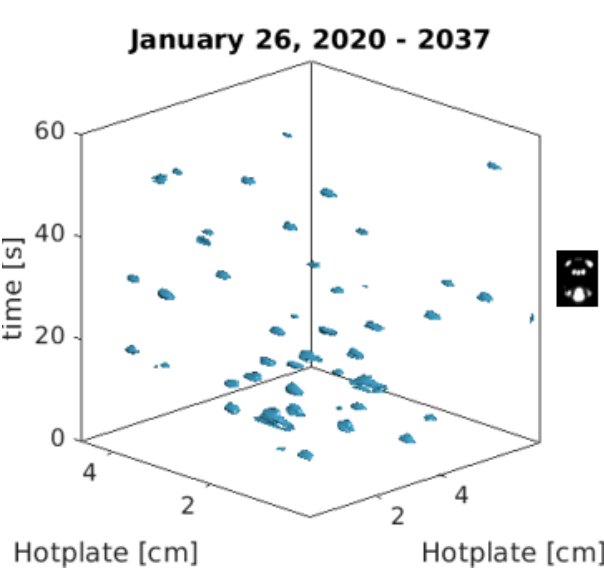
Figure B1. Volumetric rendering of melting rain hydrometeors in area on the DEID plate and in time such that each isosurface repre- sents a rain drop frozen at a point in time.